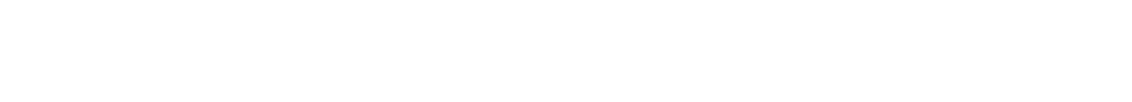
FIGURE 5 | Results of meta-analyses on intracerebral edema volume (IEV) involving 3 trials .There was statistical difference in IEV values between PNS and CT groups (MD = 10.78; 95% CI = 9.07, 12.49; P <0.00001). PNS, Panax notoginseng saponin; CT, Current